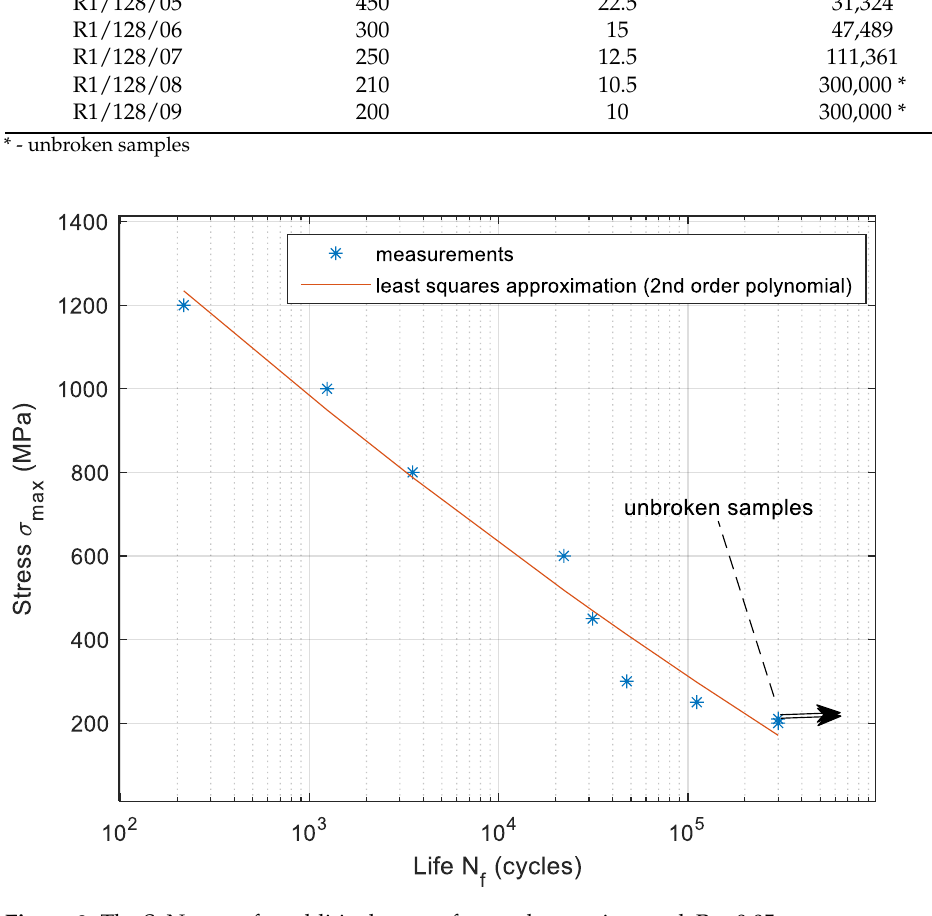
Table 3. Tensile fatigue test results. Sample No.